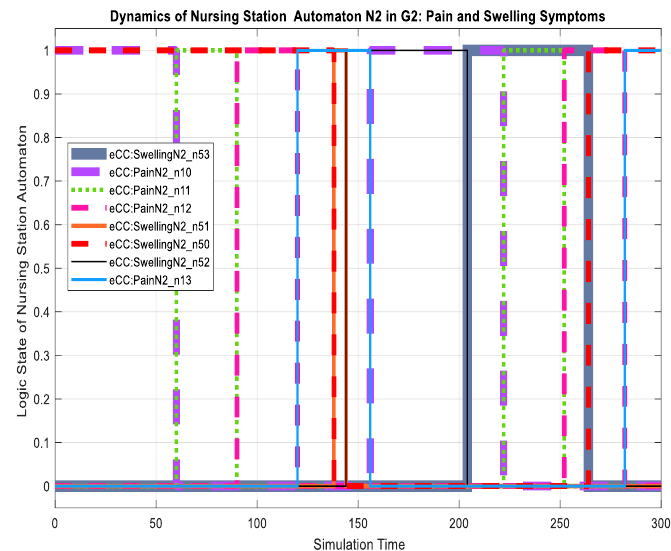
Figure 26. Dynamics of patient automaton 𝑵 𝟐 in 𝑮 𝟐 in terms of monitoring the pain and swelling symptoms.